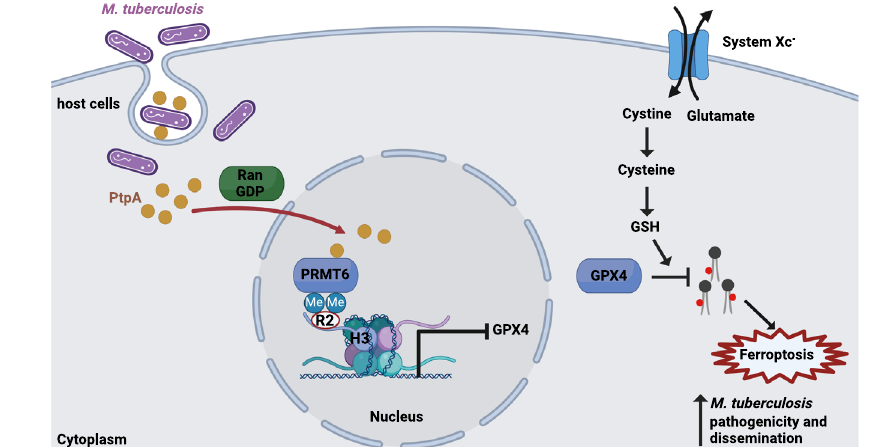
results in decreased GPX4 expression and ferroptosis induction in host cells, con- tributing to Mtb pathogenicity and dissemination. GSH glutathione; GPX4 glu- tathione peroxidase 4; Mtb Mycobacterium tuberculosis ; PRMT6 protein arginine methyltransferase 6; PtpA protein tyrosine phosphatase A; Ran-GDP